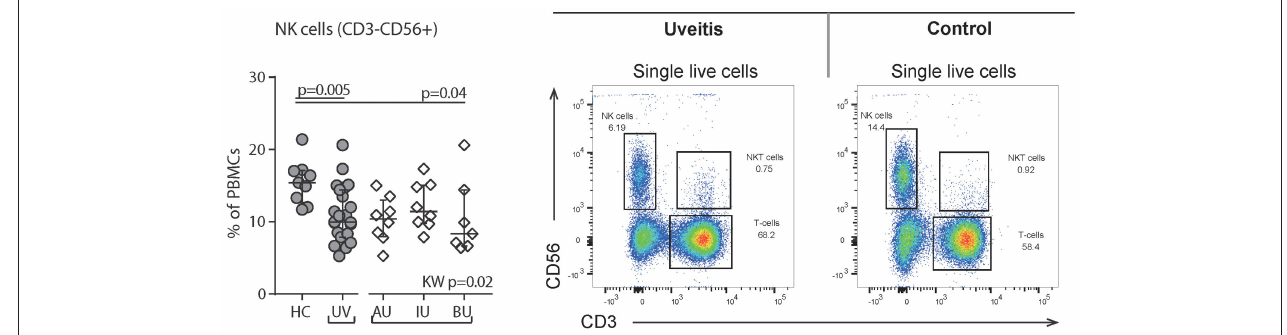
FIGURE 6 | Flow cytometry of peripheral blood mononuclear cells shows a decrease of Natural Killer (NK) cells in uveitis. Left: levels of circulating NK (CD56 + CD3-) cells as % of PBMCs. Right: gating strategy used to identify NK cells. Live single cells are gated as indicated in Figure S1 . Bars in plots indicate median, error bars indicate interquartile range. P -values between HC and UV are from Wilcoxon rank-sum test, p -values between uveitis subgroups are from Kruskal–Wallis (KW) test with post-hoc Dunn’s correction for multiple testing. AU, HLA-B27 associated anterior uveitis; BU, Birdshot uveitis; HC, healthy control; IU, idiopathic intermediate